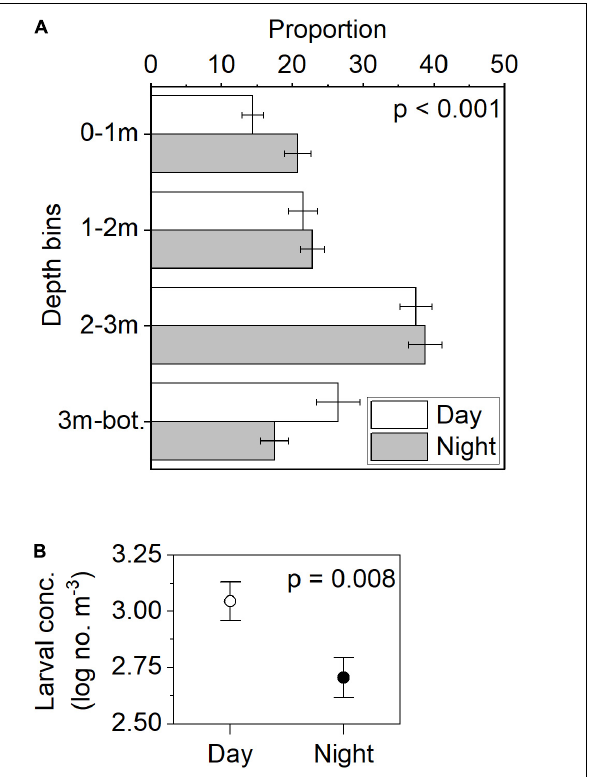
FIGURE 11 | Day-night variability in mean ( ± SE) C. fissus (A) larval vertical distribution, and (B) larval